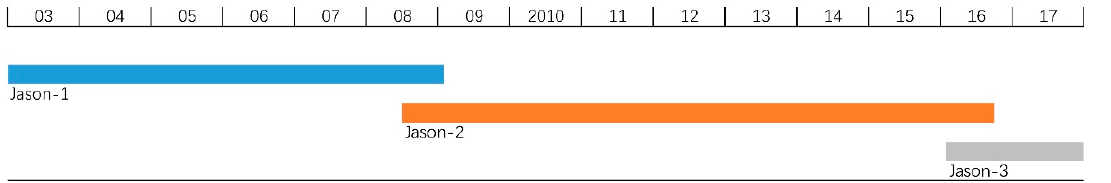
Figure 2. Jason-1, -2, and -3 altimetry data used.